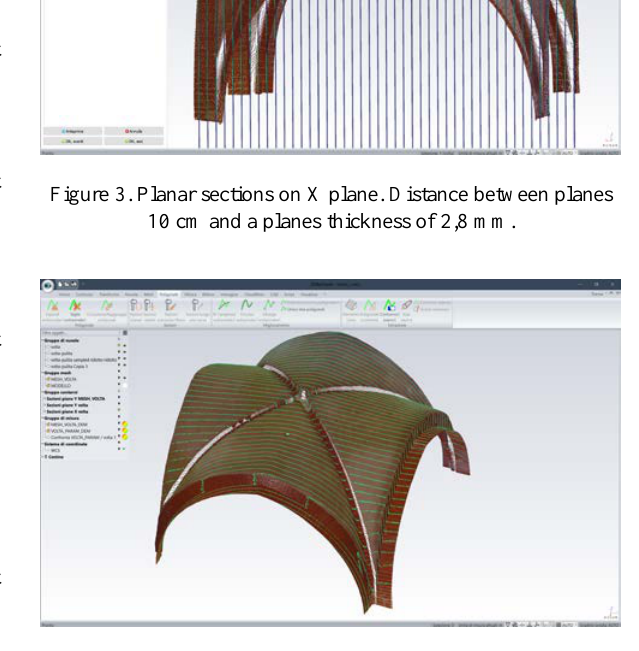
Figure 4. Profile of planar sections on X plane on the point cloud of rib